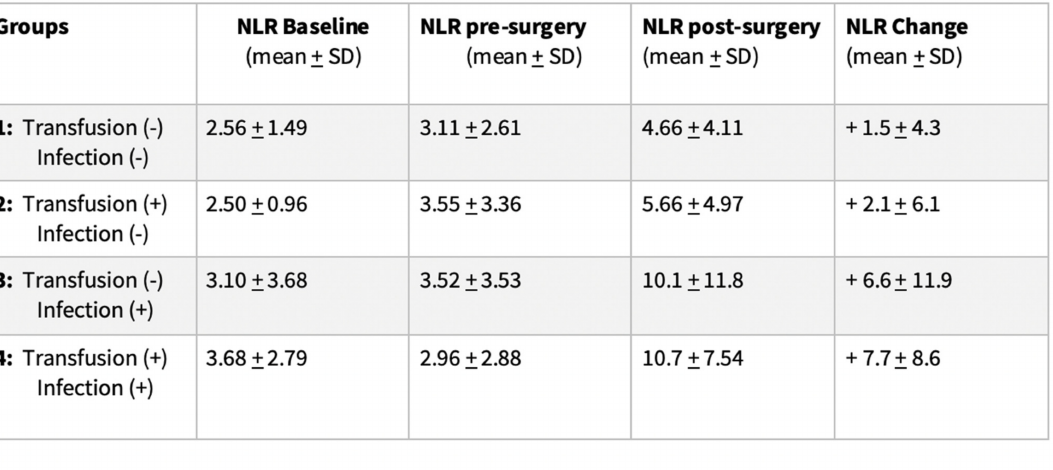
Figure 1. Perioperative neutrophil-to-lymphocyte ratio (NLR) changes classified in four groups depending on their perioperative course. Values are expressed as mean and standard deviation.